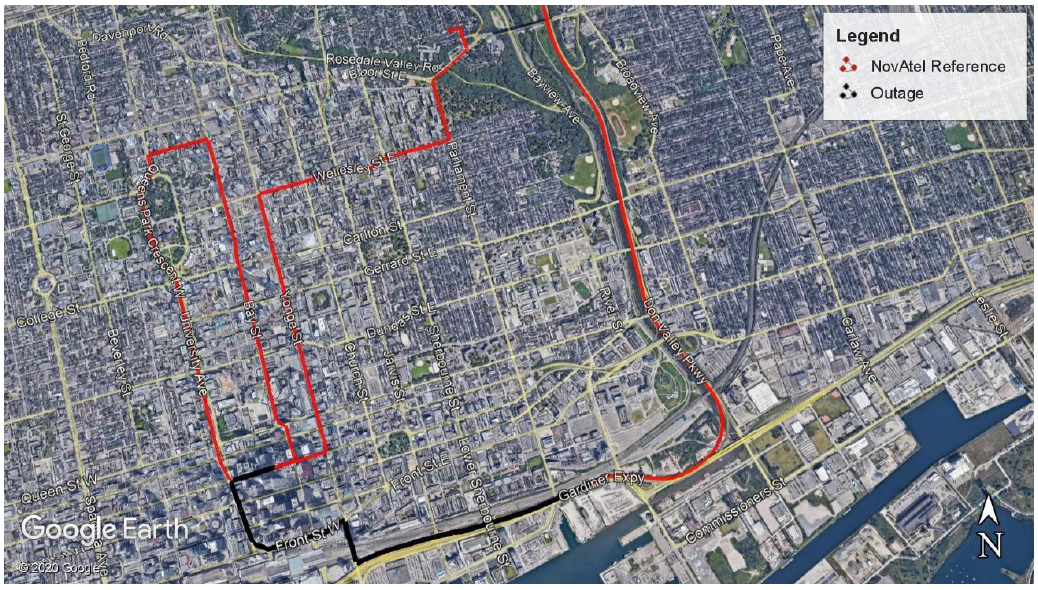
Figure 19. Second Trajectory Highlighting the Scenario.